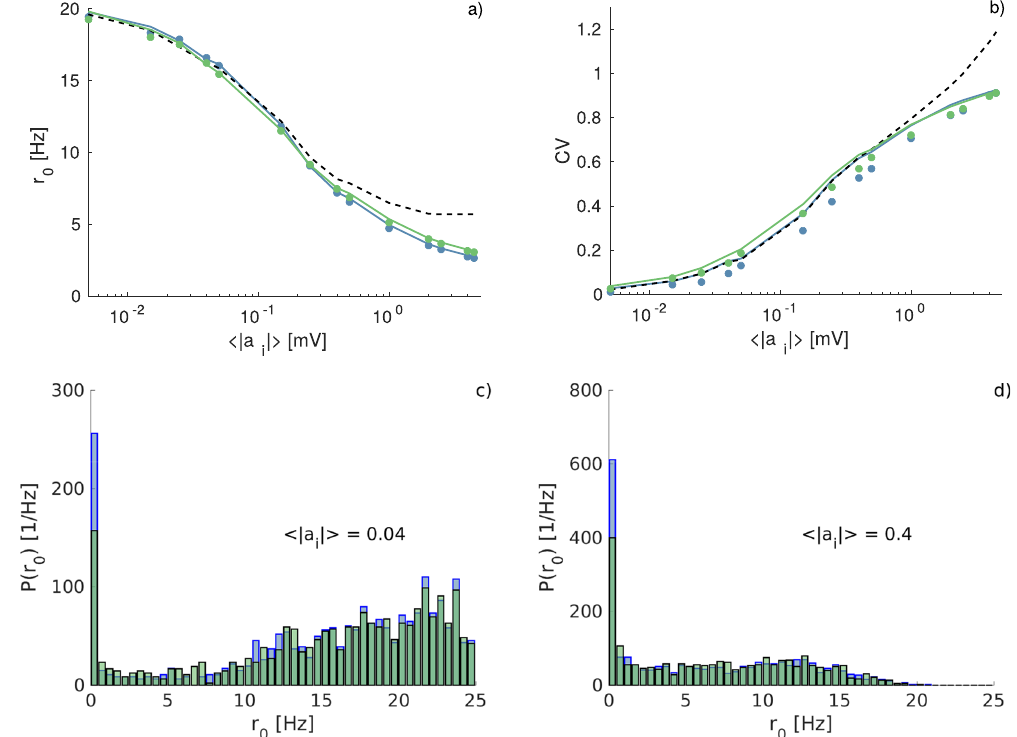
Figure 6. Firing time statistics for heterogenoeus networks as a function of the average synaptic weight. ( a ) Average network frequency r and ( b ) average coefficient of variation CV as a function of the average synaptic 0 weight 〈 | a i | 〉 for two representative IPSP distributions: DD (blue) and ED (green). Symbols correspond to simulation values and solid lines to the theoretical results from Eqs (57) and (58). Dashed line denote the results of the DA. The numerically estimated probability distribution functions P ( r 0 ) of the single neuron firing rate r 0 are also reported for the two considered IPSP distributions for two values of the average synaptic weight: namely 〈 | a i | 〉 = 0.04 ( c ) and 〈 | a i | 〉 = 0.4 ( d ). Simulations were performed with N = 400 neurons, K = 20 and a distribution of the input currents uniformly chosen in the interval μ ( j ) ∈ [10, 11] mV. The time averages are calculated, after discarding an initial transient corresponding to 10 6 spikes, over the following 10 6 spikes. Silent neurons (those that do not emit any spike in the considered time lapse) are not included in the statistics. In all cases 〈 | a i | 〉 denotes the average value of the corresponding